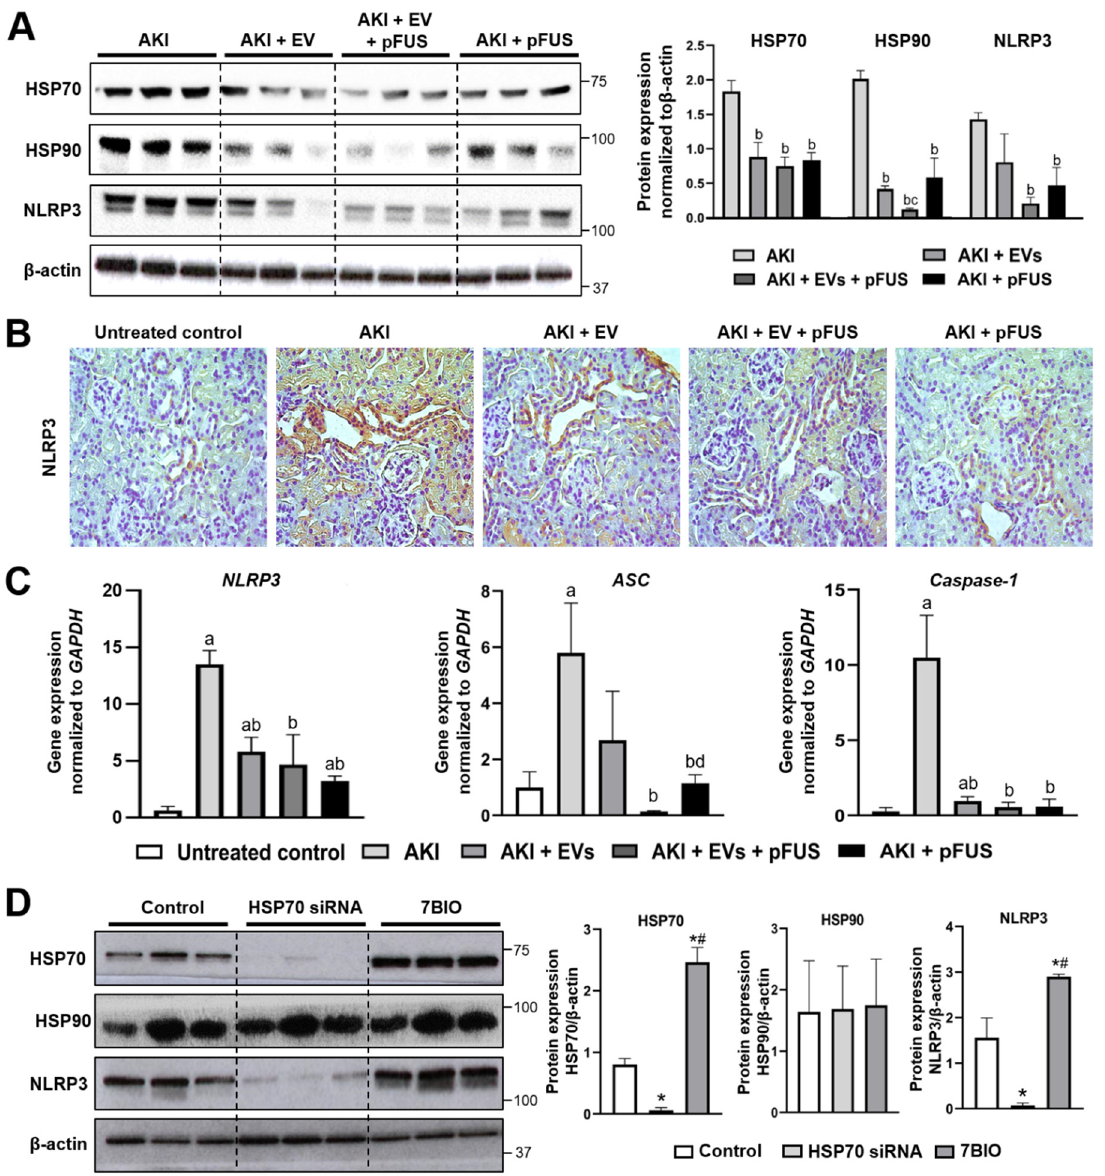
Figure 2. HSP70 regulation of the NLRP3 inflammasome. ( A ) Western blot and quantification showing the expression of HSP70, HSP90, NLRP3, and β -actin in kidney tissue. ( B ) Immunohistochemical staining for NLRP3 in kidney tissue. ( C ) qRT-PCR measurement of inflammasome components NLRP3 , ASC , and Caspase-1 expression in kidney tissue, normalized to GAPDH . ( D ) Western blot and protein quantification showing expression of HSP70, HSP90, NLRP3, and β -actin in human embryonic epithelial (HEK) cells treated with DMSO (control), an HSP70-siRNA, or 7BIO. Each group has n = 3 mice. Significant difference a p < 0.05 relative to untreated control; b p < 0.05 relative to AKI; c p < 0.05 relative to AKI + EVs; d p < 0.05 relative to AKI + EVs + pFUS; * p < 0.05 relative to DMSO control; # p < 0.05 relative to HSP70-siRNA.